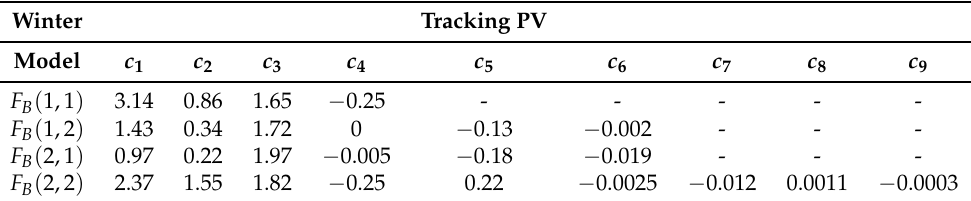
Table 5. Optimal coefficient values model B for sun tracking PV